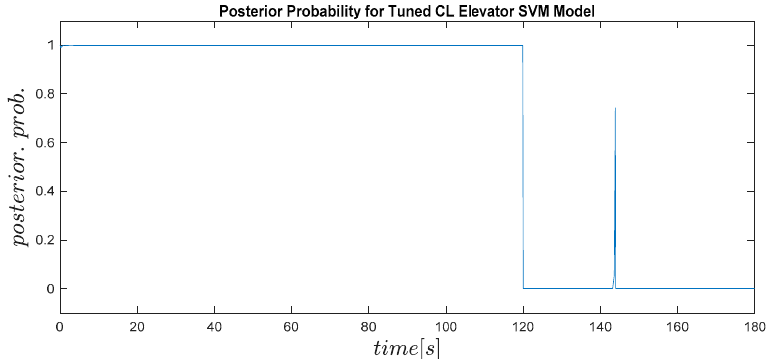
Figure 19. The posterior probability plotted against time for the tuned CL elevator SVM model.